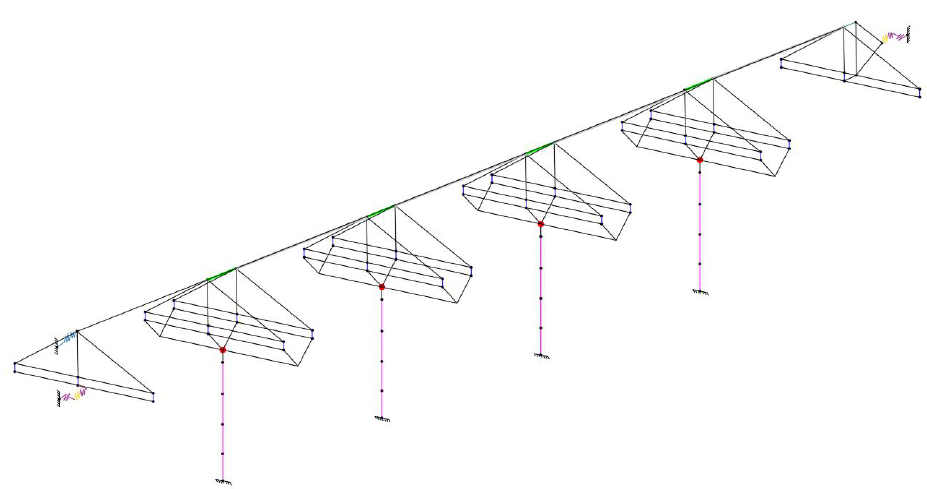
Figure 10. Three-dimensional view of the finite element model of the bridge.